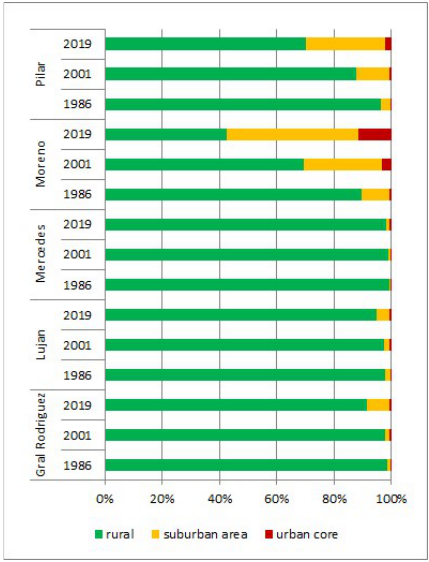
Figure 4. Built-up areas ratio by municipality